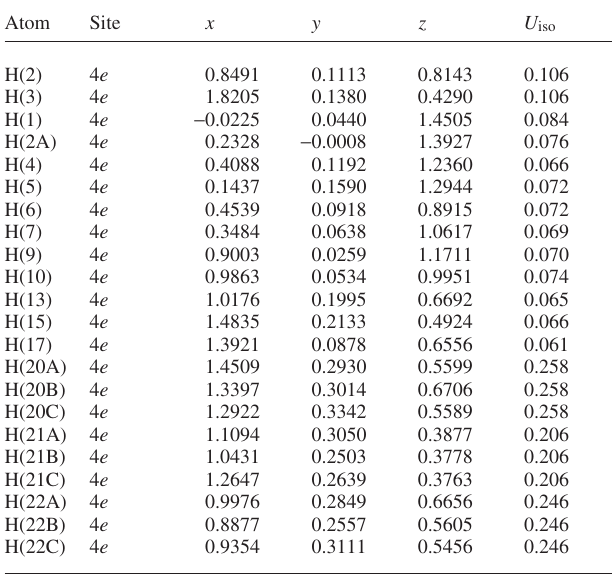
Table 2. Atomic coordinates and displacement parameters (in Å 2 )